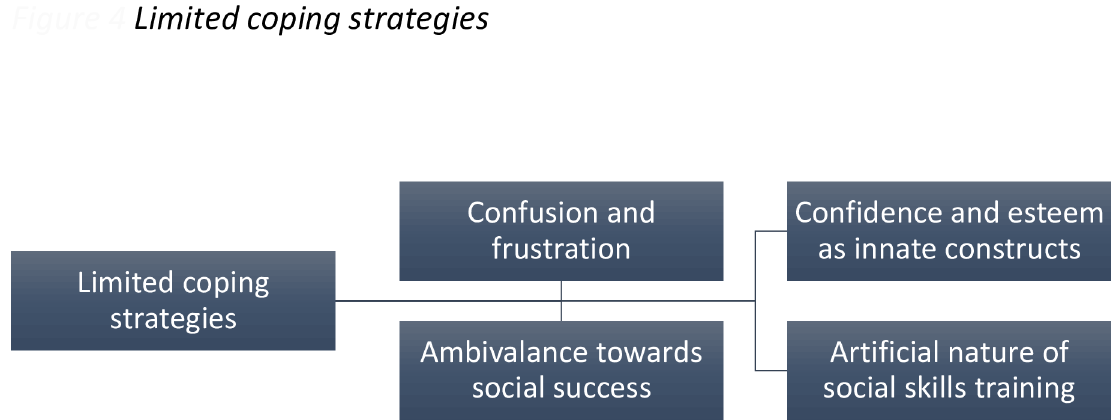
Fig 4. The furthest left hand box indicates the superordinate themes, with the subordinate themes in the remaining boxes. The connecting lines indicate the hierarchical organisation of the themes.